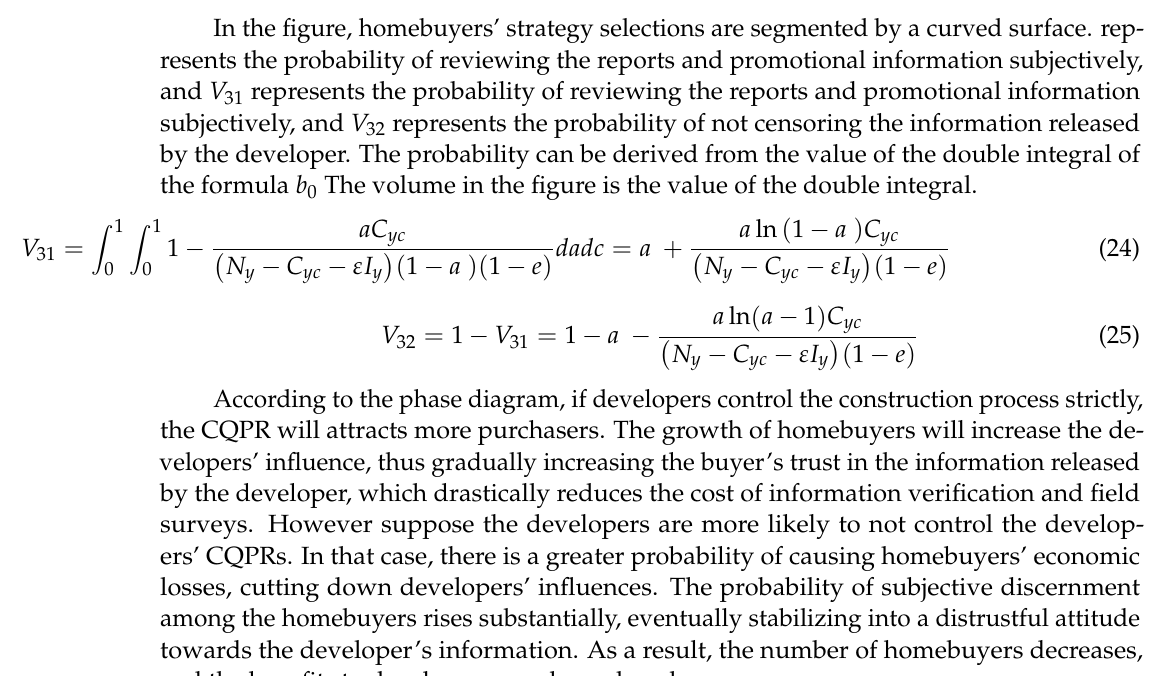
Figure 5. Strategy selection phase diagram of homebuyers.